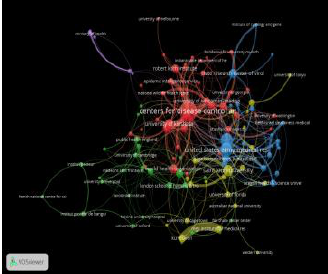
Figure 3. Co-occurrence map of organizations in MPX